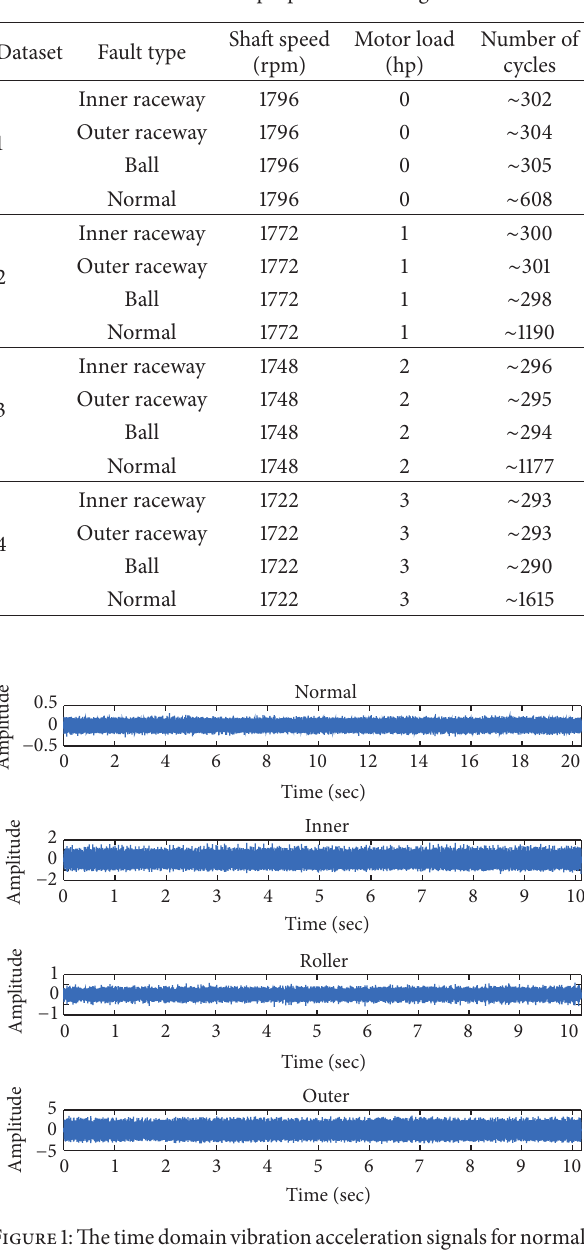
Table 3: Datasets for the proposed fault diagnosis scheme.